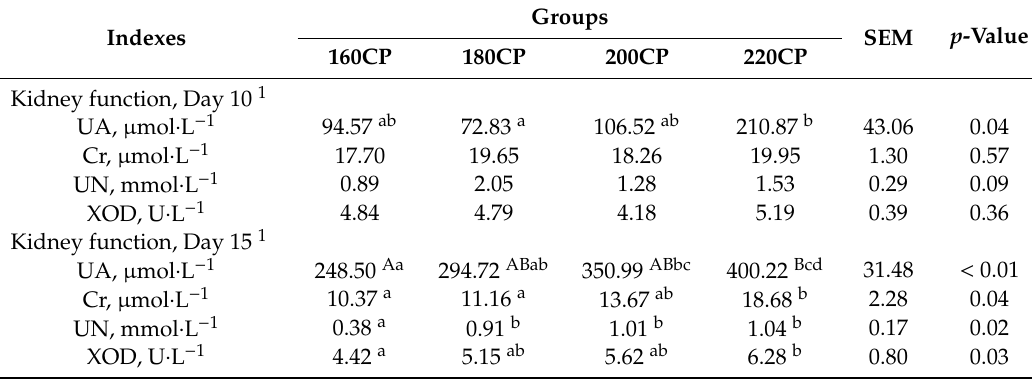
Table 3. E ff ects of protein levels on kidney function in goslings in Experiment One.